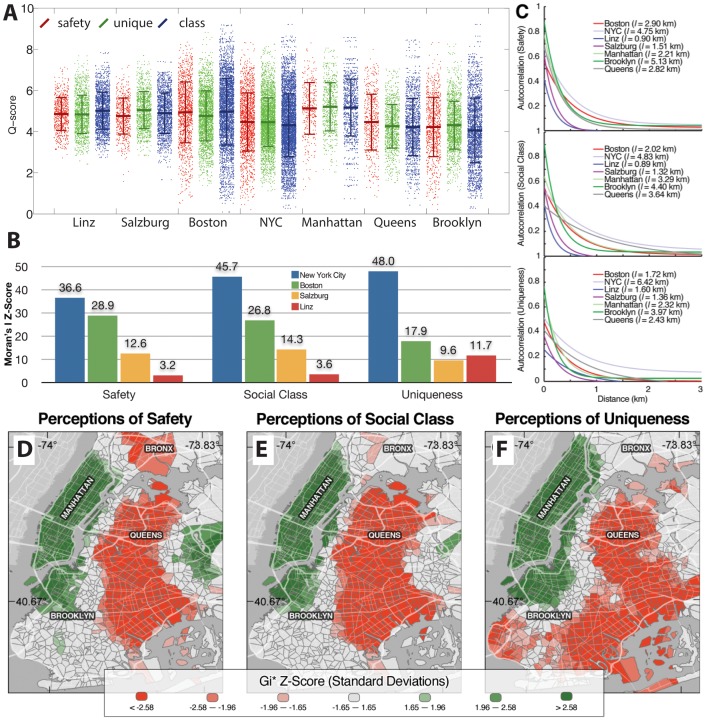
Contrasts in urban perception.
A. Scatter plot showing the Q-scores obtained for each image, city and question. Top and bottom whiskers represent one standard deviation. B. Moran's I z-scores for each city and question (all p-values<0.01, see SM). C. Spatial correlograms showing the decay of spatial autocorrelation as a function of distance. D–F. Map of NYC showing statistically significant clusters of high -and low- Q-scores for the perception of safety, class and uniqueness according to Getis Gi* statistic. Green shows clusters of positive perceptions (high Q-scores) and red shows clusters of negative perceptions (low Q-scores).